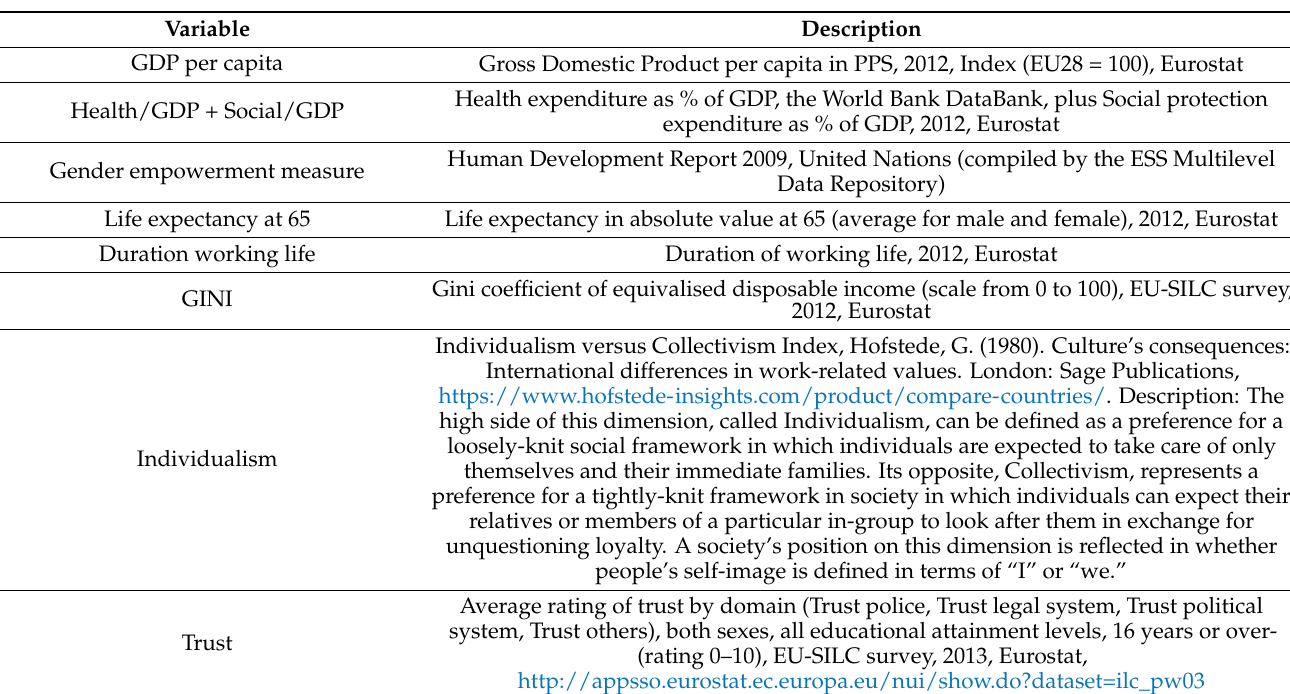
Table A3. Variables used in factor analyses of welfare state.